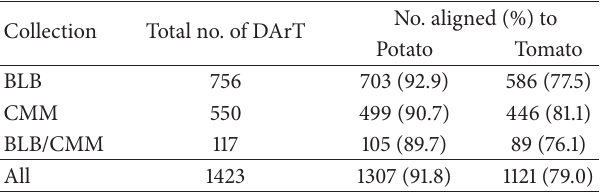
Table 1: Results of DArT alignments to potato and tomato reference genomes. For each collection, the total number of DArT markers and the number (%) of aligned DArT markers are